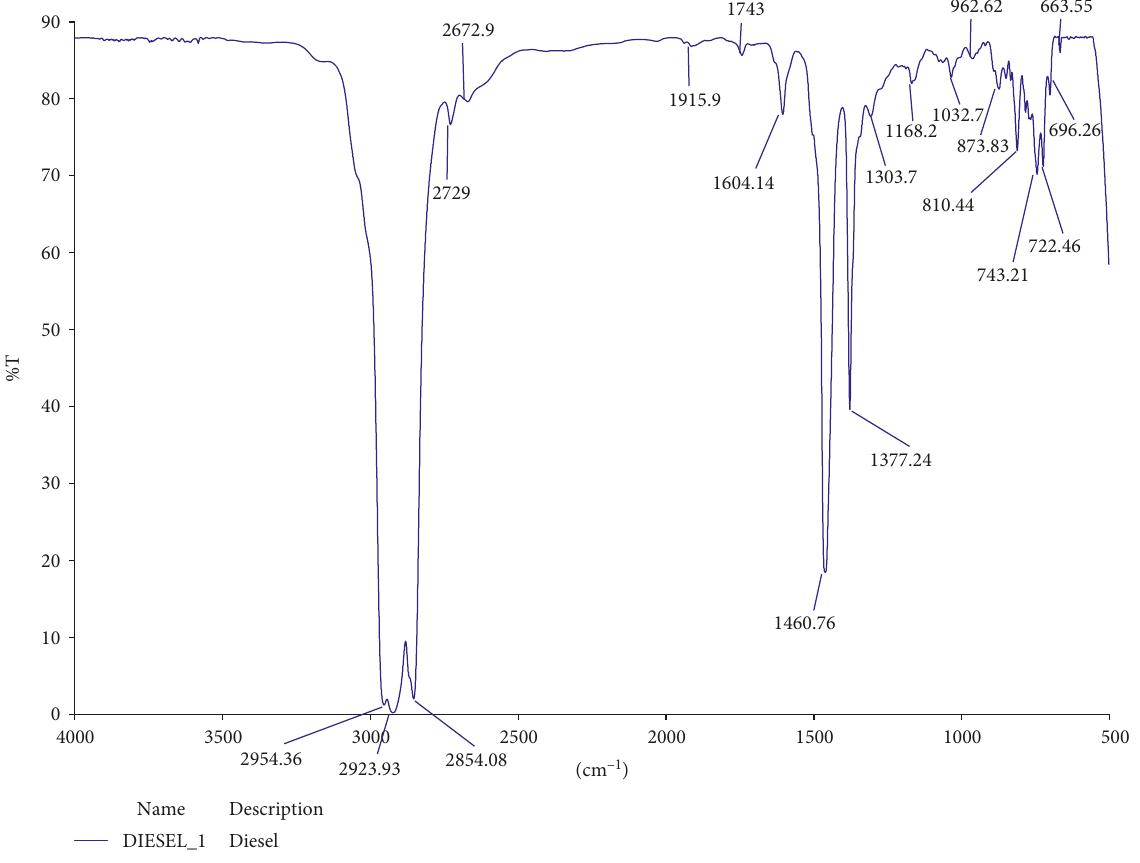
Figure 5: Diesel FTIR